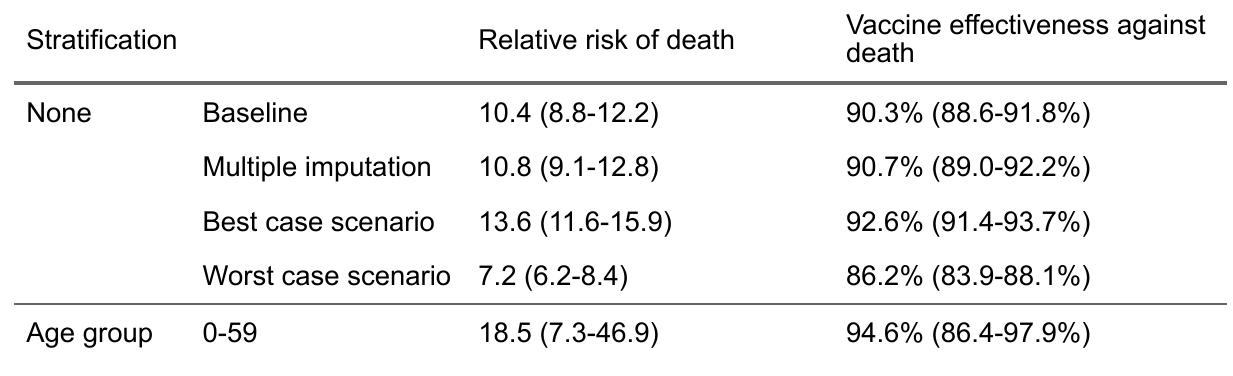
Table S2. Relative risk of death (and 95% confidence intervals) for non-fully vaccinated compared to fully vaccinated, with the corresponding estimations of vaccine eectiveness against